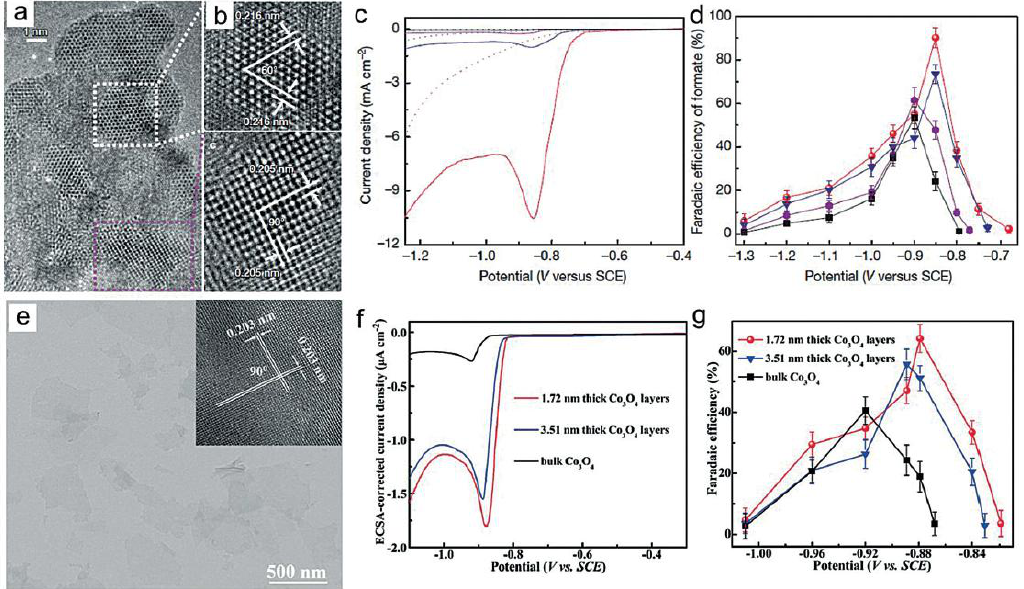
Figure 5. ( a , b ) TEM images of the partially oxidized Co 4-atom-thick layers; ( c , d ) Linear sweep voltammograms and the Faradaic efficiency for formate on partially oxidized Co 4-atom-thick layers (red), Co 4-atom-thick layers (blue), partially oxidized bulk Co (violet), and bulk Co (black). Adapted with permission from Ref. [44]. Copyright 2016, Nature Publishing Group. ( e ) Typical TEM image for Co 3 O 4 atomic layers with an average thickness of 1.72 nm. ( f , g ) Linear sweep voltammograms and Faradaic efficiency for formate on Co 3 O 4 with different thicknesses. Adapted with permission from Ref. [45]. Copyright 2016, Wiley-VCH Verlag GmbH & Co. KGaA.